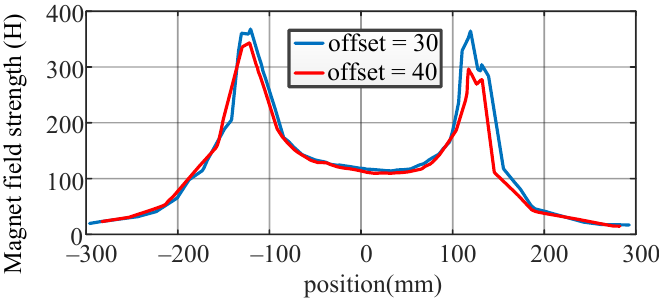
Figure 34. Magnetic field strength curves with the proposed structure and larger offsets of the